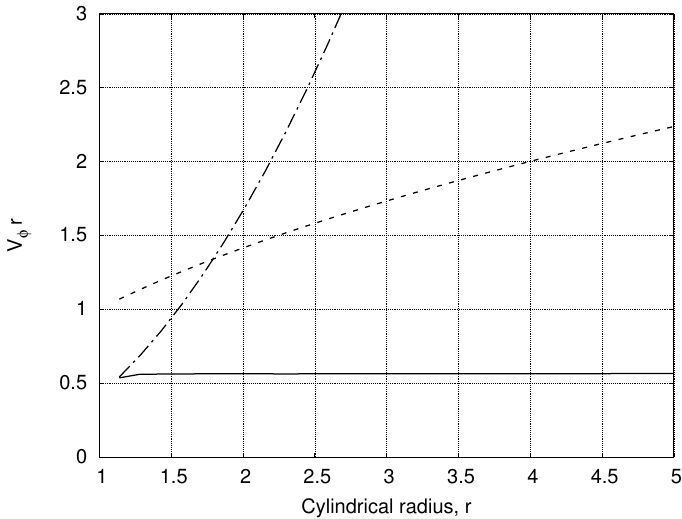
Figure 7. Solid line—dependence of the angular momentum V ϕ r on r at the equator. Dashed-dotted line—the same dependence at the rigid body rotation and dashed line is the dependence at the Kepler